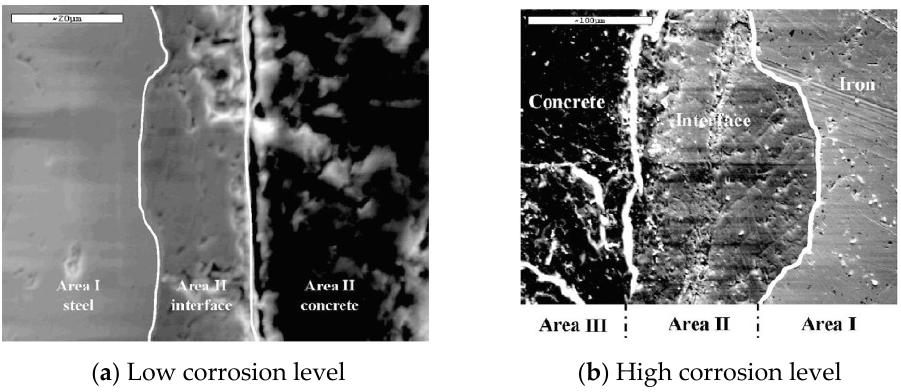
Figure 5. SEM observations at the steel–concrete interface. Reproduced with permission from [82], Elsevier, 2006.